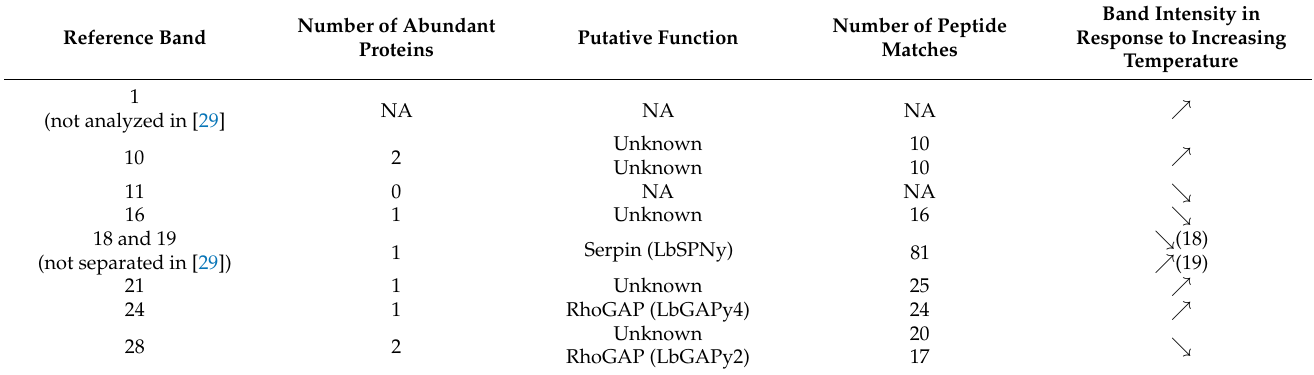
Table 2. Match between temperature-affected ISy protein bands and their putative protein content determined from comparison with data from [29]. Only proteins for which at least 10 peptide matches were found in Mascot searches with unisequences identified in the venom apparatus transcriptomics [29] were considered abundant and were therefore listed. The number of proteins found in the band, their predicted function and the number of peptide matches for each unisequence are provided. Up (“ (cid:37) ”) and down (“ (cid:38) ”) arrows indicate an increase or decrease in band intensity in response to increasing temperature. NA: data not available.